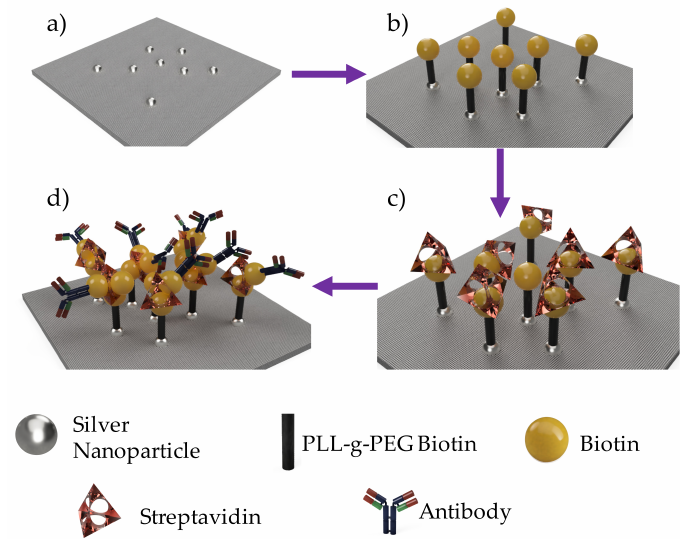
Figure 1. Schematic of surface functionalization steps to immobilize antibody onto nanofiber